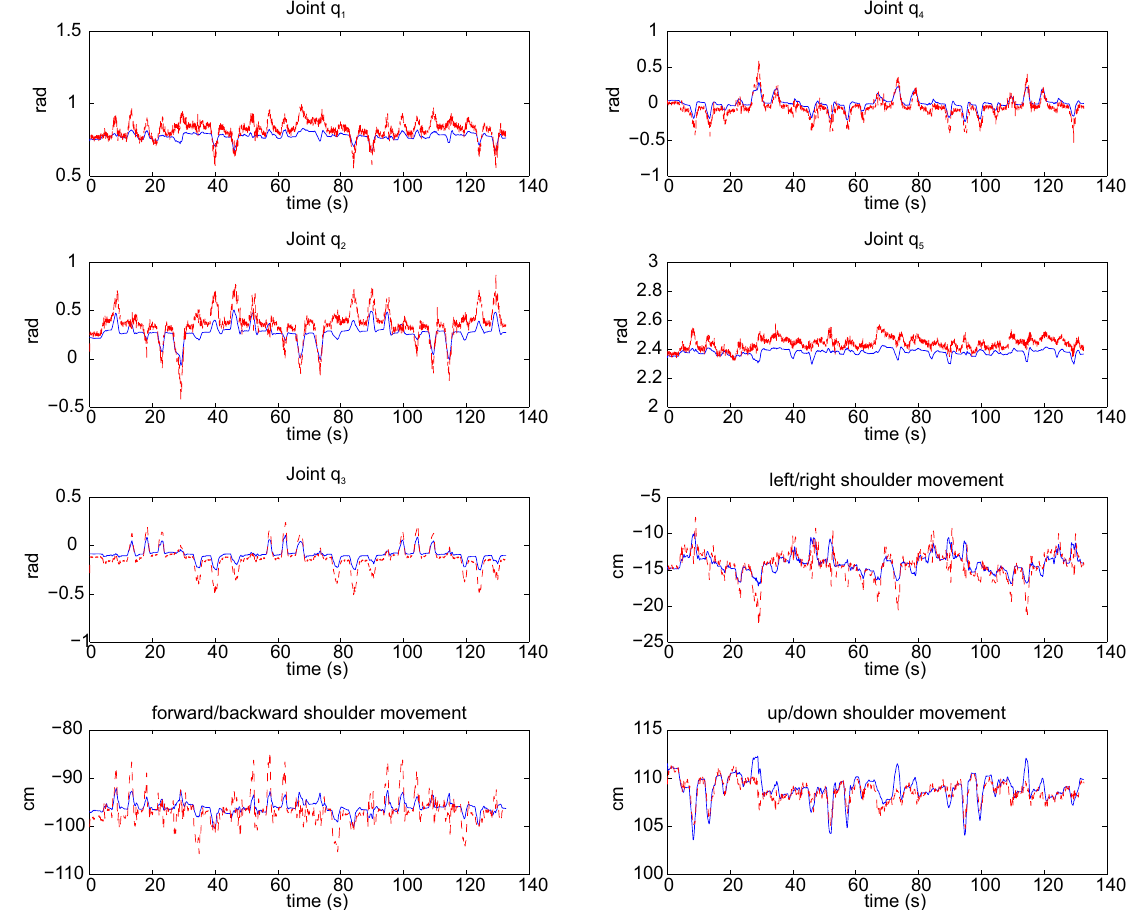
Figure 6. Joints and shoulder movements estimated through the algorithm (dotted red line) and measured through the optoelectronic system (blue line) of a subject during an